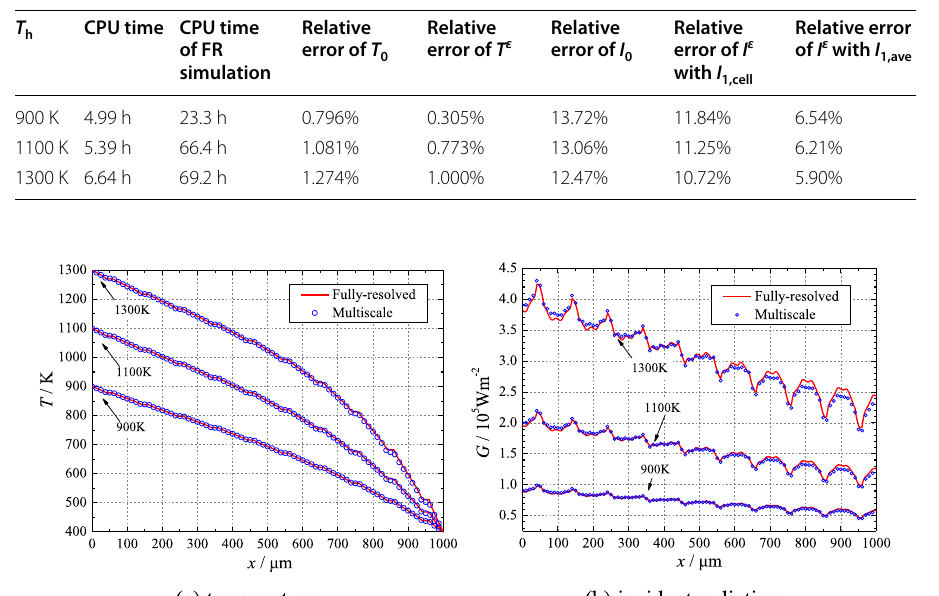
(FR represents h